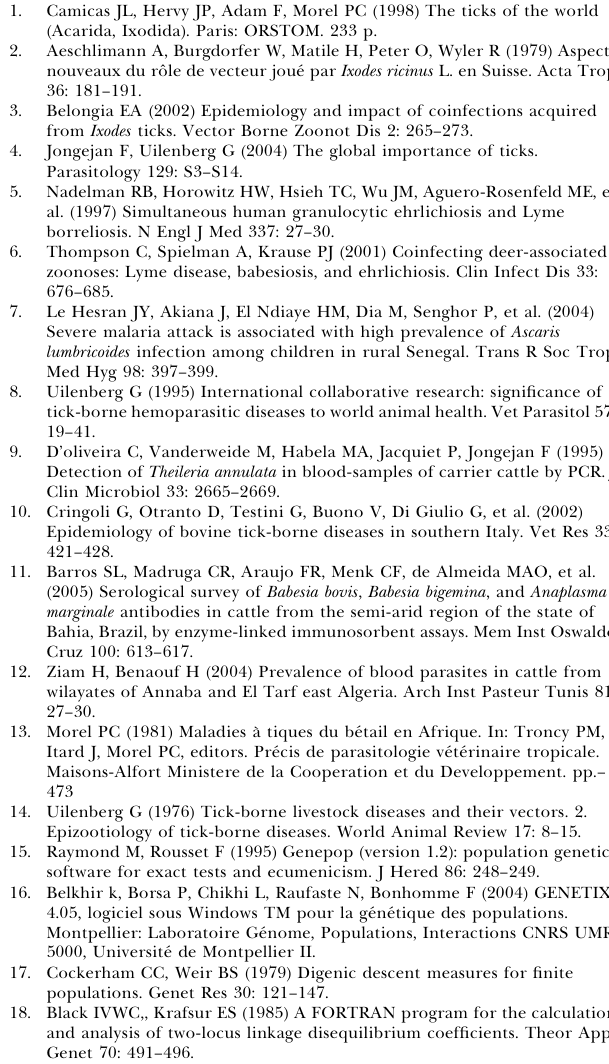
Figure S1. A Typical Landscape of El-Tarf Wilaya around Boutheldja, on the Northeast Border of Algeria (Close to Tunisia), East of Annaba in